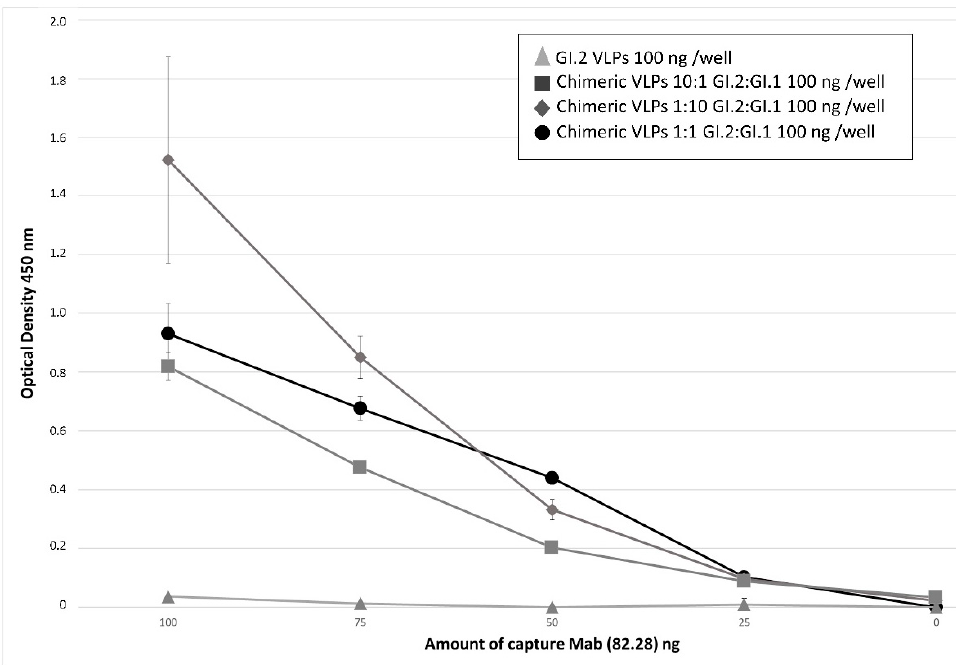
Figure 2. Sandwich ELISA using serotype-specific Mabs for capture and detection of chimeric VLPs. ELISA plate wells were coated with decreasing quantities of GI.1 (AST89)-specific Mab 82.28 (100, 75, 50, or 10 ng). The graph shows mean optical densities (450 nm) ± SD ( n = 3), Following incubation with GI.2 VLPs or chimeric VLPs produced by co-infection of baculovirus in insect cells at varying ratios (GI.2:GI.1 of 10:1 (grey squares), 1:10 (grey diamonds), and 1:1 (black circles), binding was detected using peroxidase-conjugated GI.2-specific Mab 2D9. Optical density values measured at 450 nm are shown. Positive detection of chimeric VLPs indicates the incorporation of GI.1 and GI.2 VP60 in the same VLPs.